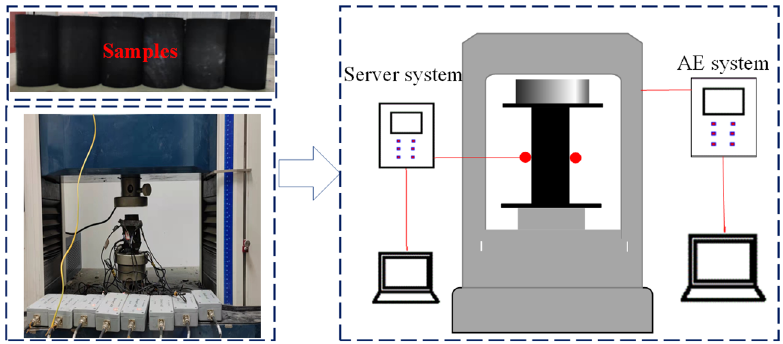
Figure 1. Test equipment and test samples.